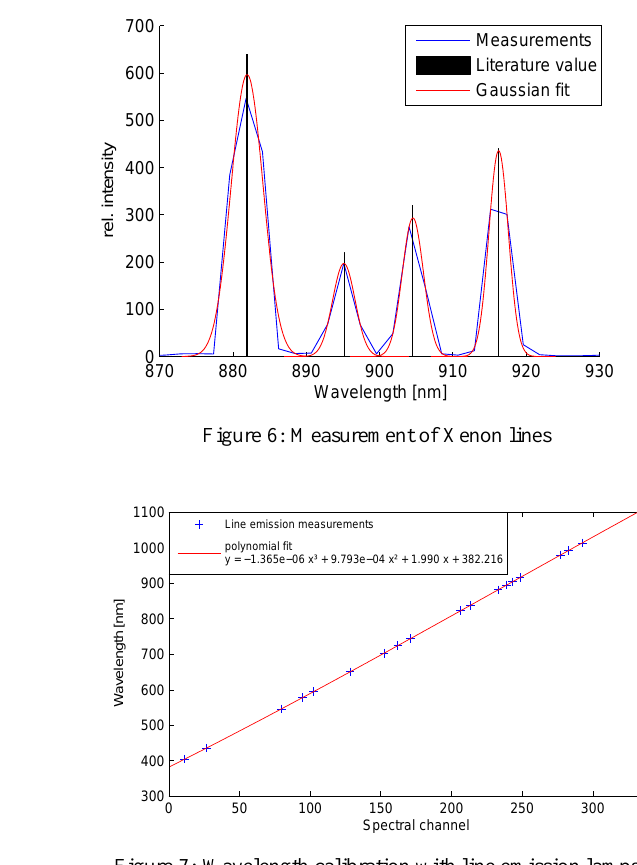
Figure 7: Wavelength calibration with line emission